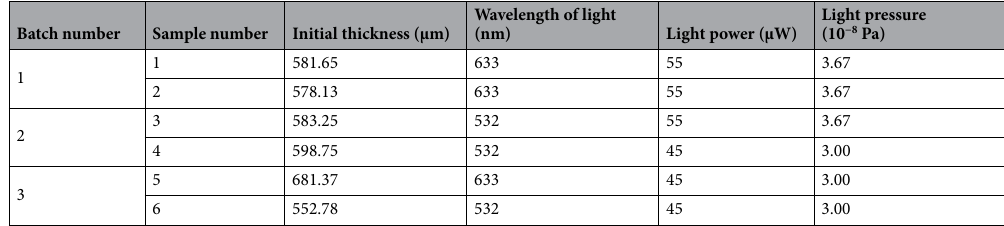
Table 1. sample thickness and stress parameters of the laser light.